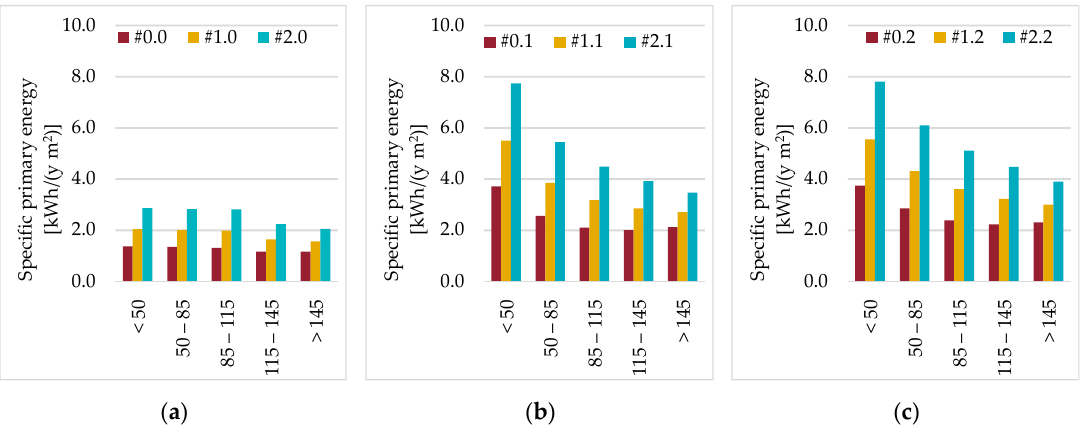
Figure 17. Naples: Specific primary energy consumption for cooling. ( a ) Existing equipment; ( b ) Figure17. Naples: Specificprimaryenergyconsumptionforcooling. ( a )Existingequipment; ( b )existing existing equipment + 1 air conditioner; ( c ) existing equipment + 2 air conditioners. equipment + 1 air conditioner; ( c ) existing equipment + 2 air